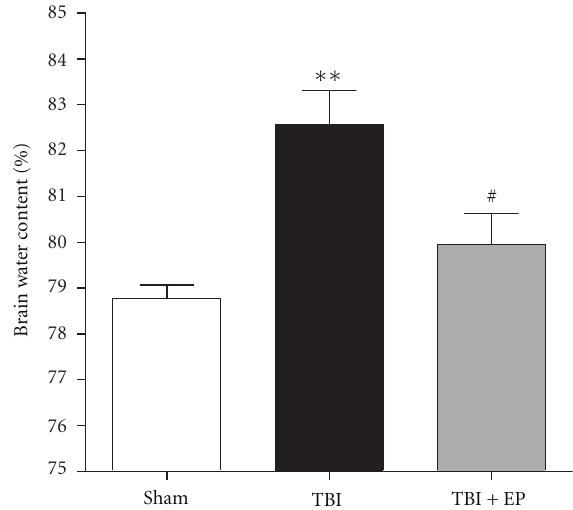
Figure 3: Alteration in brain water content in Sham group, TBI group, and TBI + EP group. The brain water content was increased significantly at 24 hours after TBI. EP administration markedly decreased brain water content 24h after TBI. Bars represent as mean ± SEM; n = 6, each group; ∗∗ P < . 01 versus Sham group, # P < . 05 versus TBI